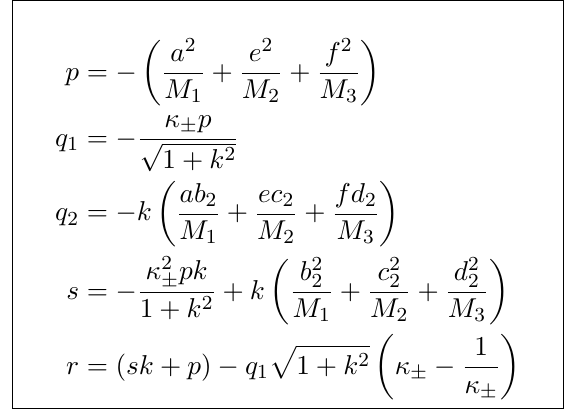
Table 1 . Parameters of M (cid:23)